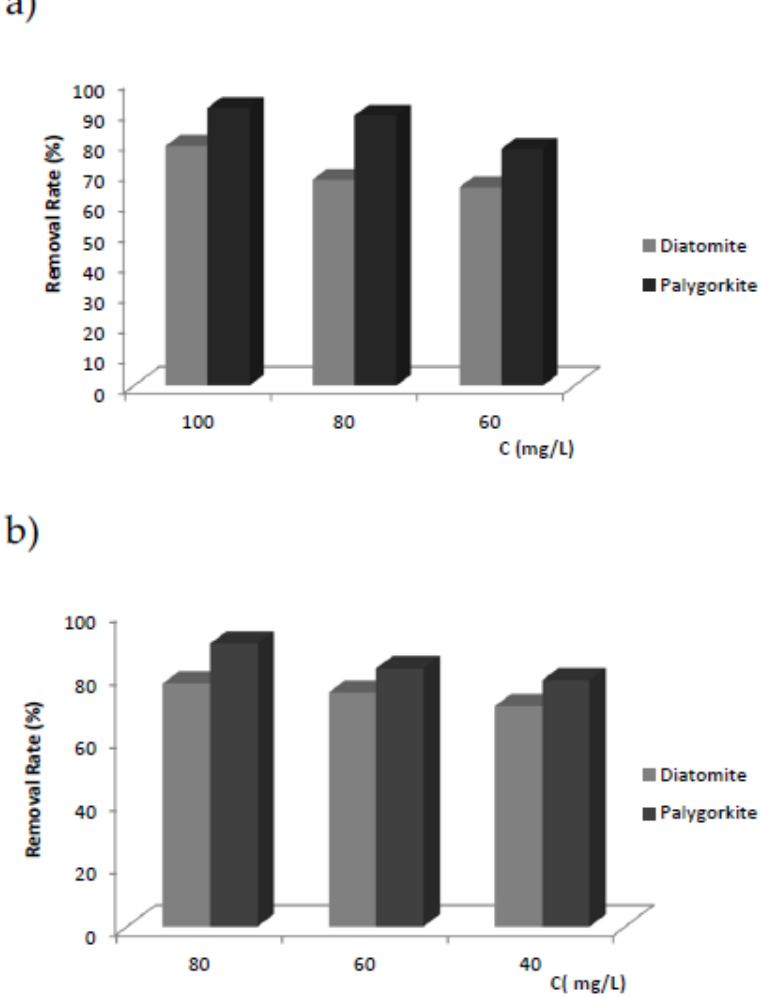
Figure 4. Percentage of removal of Cu 2+ and Ni 2+ by diatomite and palygorskie (m adsorbent = 0.5 g, v = 300 rpm, T = 25 °C, pH Cu2+ = 4., pH Ni2+ = 7).